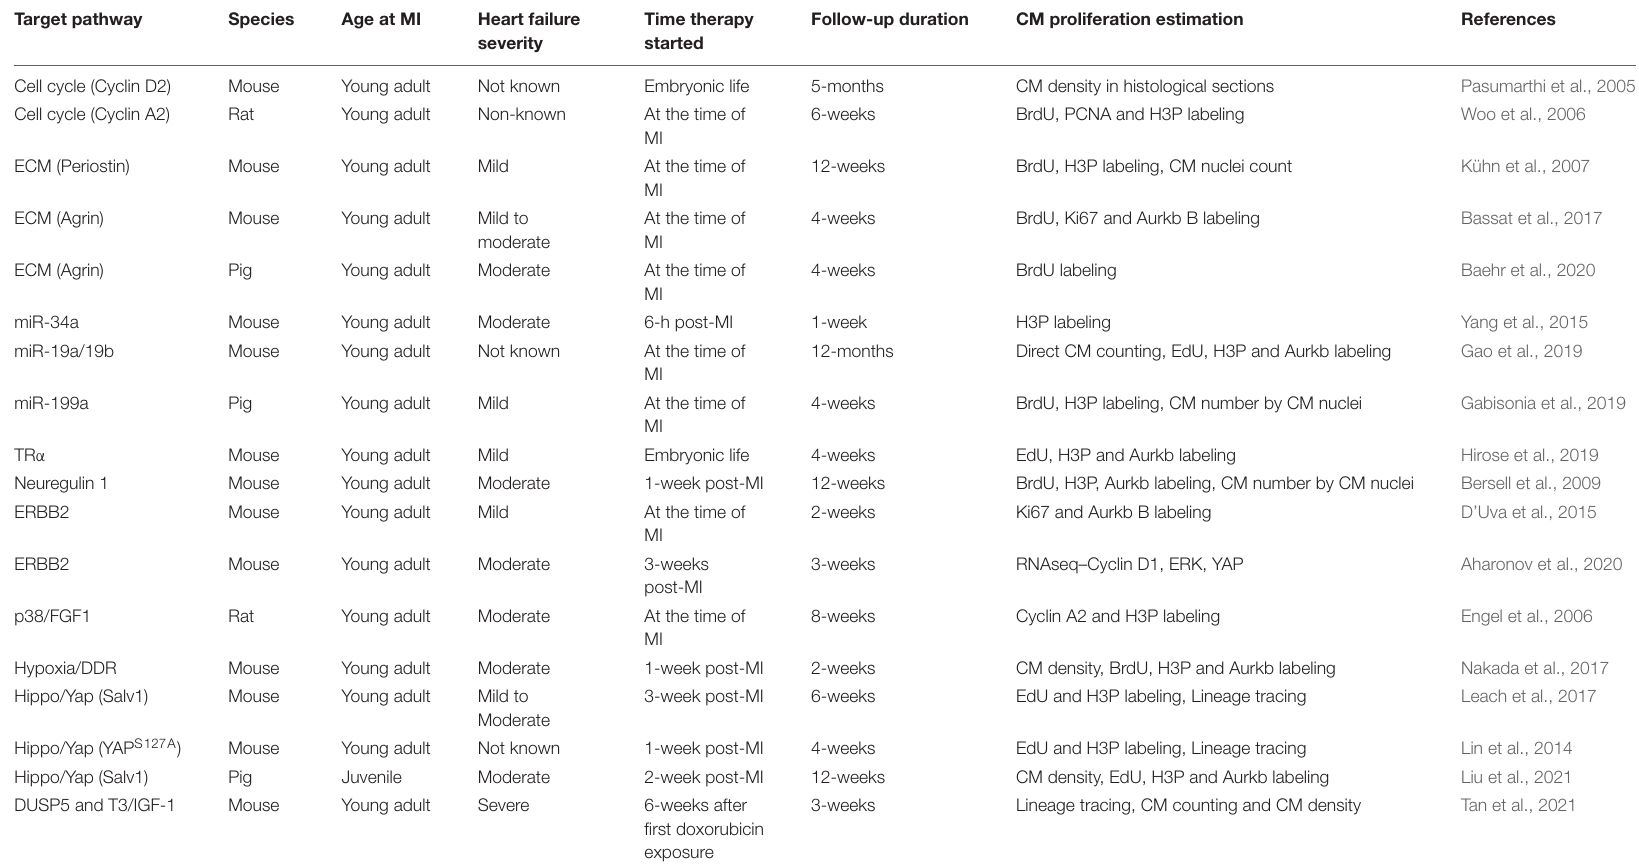
TABLE 1 | Summary of mechanism-based regenerative strategies in preclinical studies. Target